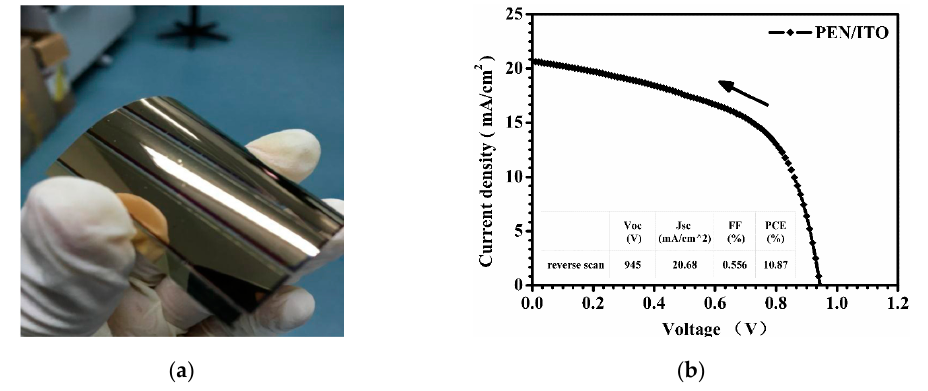
Figure 8. ( a ) Photographic image of the flexible device with a large area of 5.0 cm × 5.0 cm and ( b ) J-V curve of the flexible device fabricated by using the optimized parameters of ultrasonic spraying on polymer ITO-PEN substrate, tested under AM 1.5 G sunlight (100 mW/cm 2 ) using a metal mask of 0.16 cm 2 .